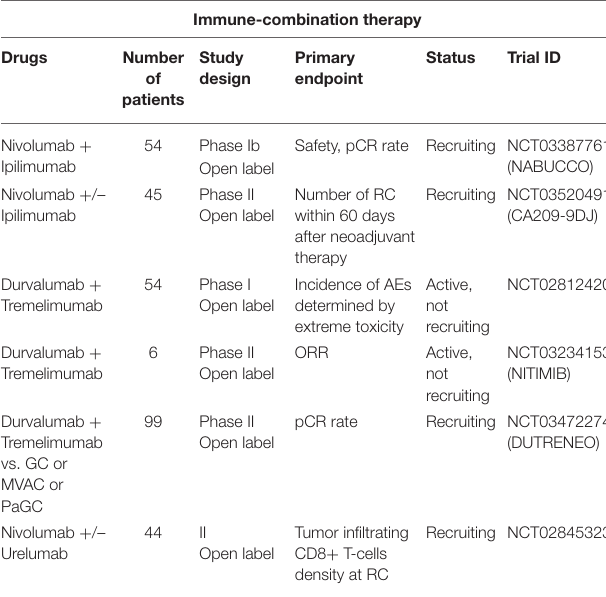
TABLE 2 | Overview of selected neoadjuvant trials in MIBC testing immune combination therapy.